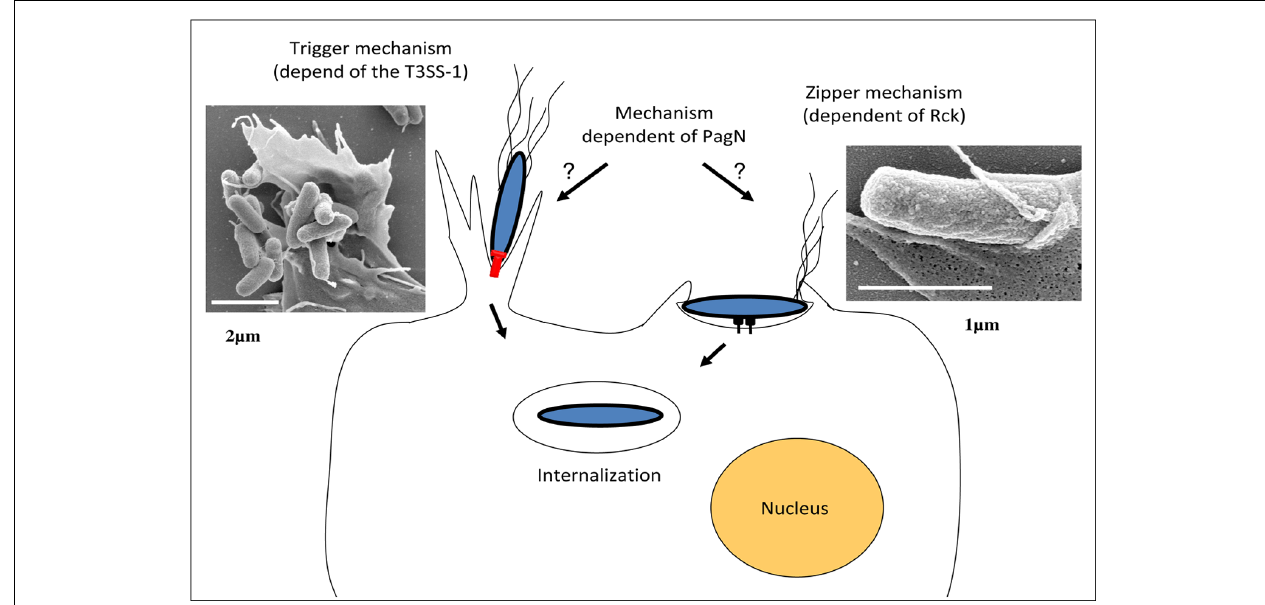
invade cells via aT3SS-1-independent mechanism, which is induced by the Salmonella Rck membrane protein interacting with its receptor on the host cell plasma membrane and characterized by the induction of thin membrane extensions (right side; Bar of the transmission electron microscopy picture represents 1 μ m).The membrane rearrangements induced by the Salmonella invasin PagN have not been studied